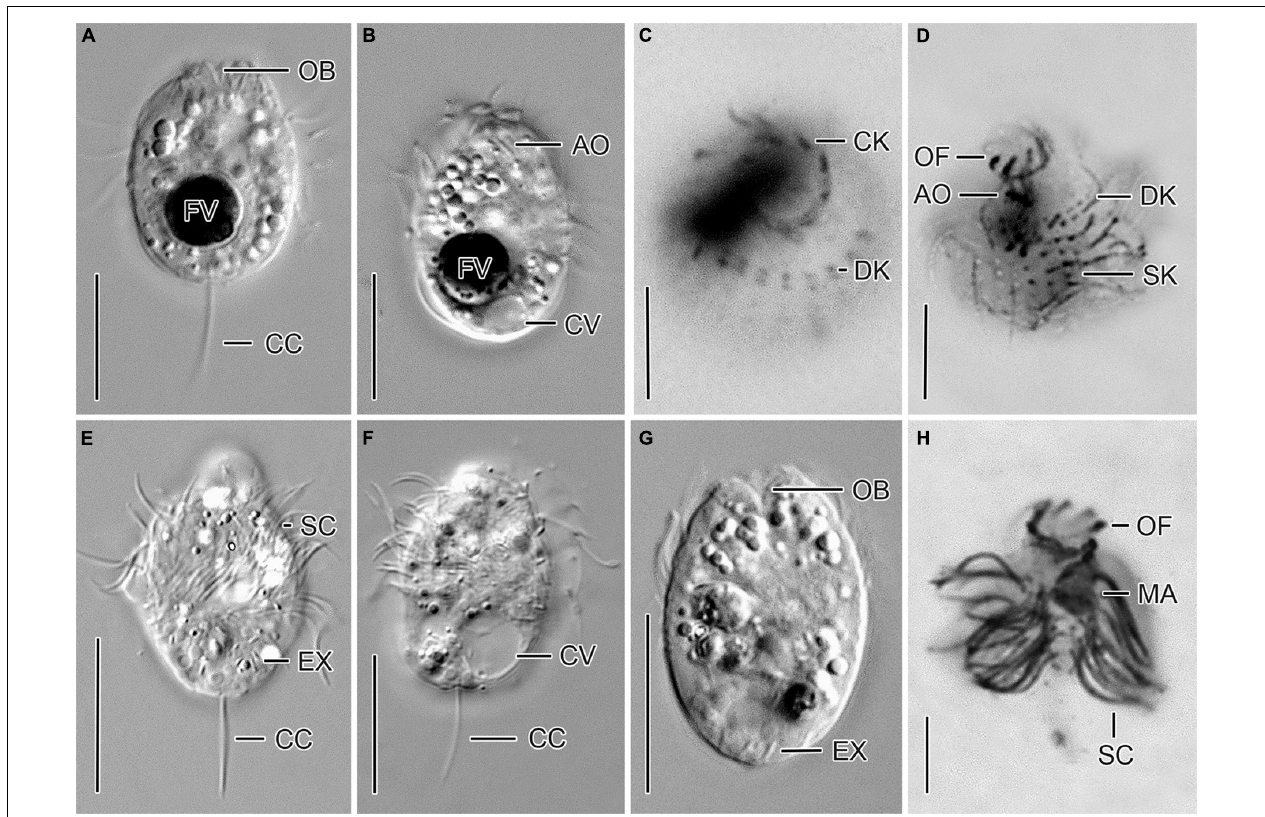
FIGURE 1 | Cryptic species tentatively identified as Urotricha agilis . Specimens of strain CIL-2017/24 from Lake Mondsee (A–D) and of strain CIL-2019/10 from Lake Piburg (E–H) in vivo (A,B,E–G) and after protargol staining (C,D,H) . (A,B,E–G) Longitudinal optical sections. (C,D) Top view and oblique top view. (H) Lateral view. AO, adoral organelles; CC, caudal cilium; CK, circumoral kinety; CV, contractile vacuole; DK, dikinetids at anterior end of somatic kineties; EX, extrusome; FV, food vacuole; MA, macronucleus; OB, oral basket; OF, oral flaps; SC, somatic cilia; SK, somatic kineties. Scale bars 10 µ m (A,B,E–G) , 5 µ m (C,D,H)